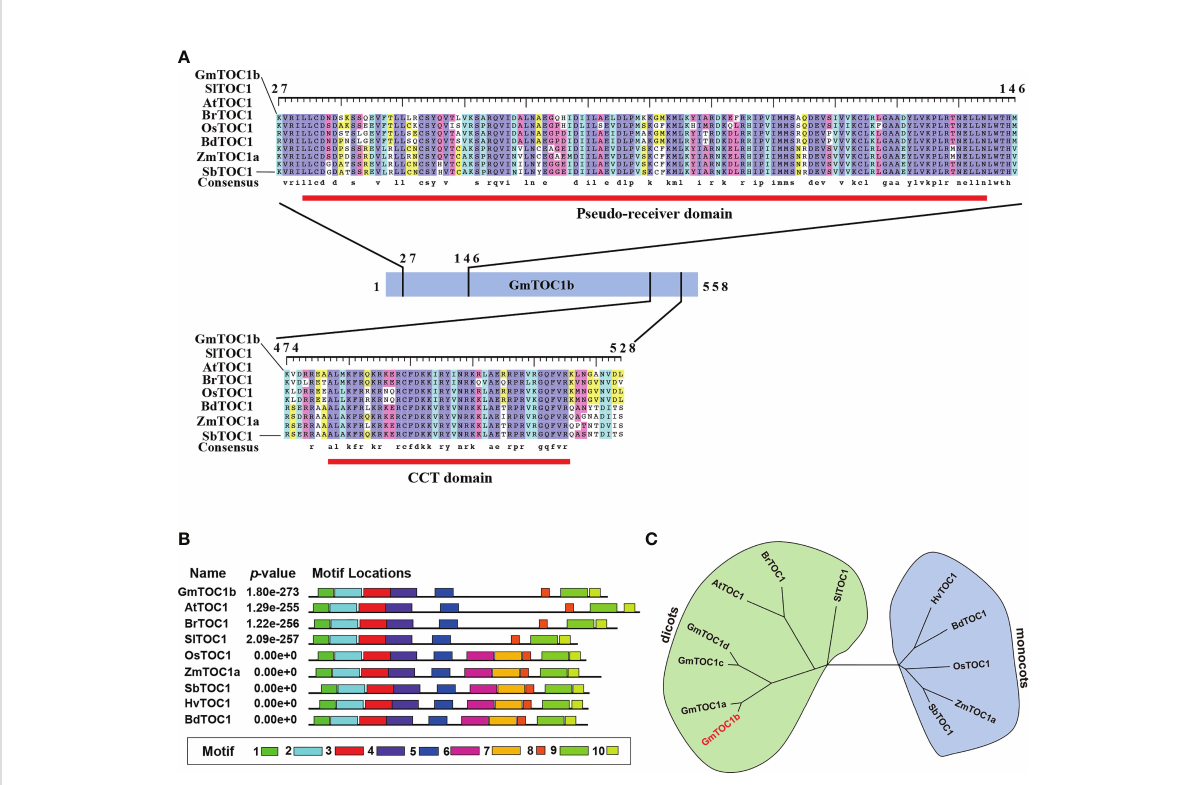
FIGURE 1 Analysis of TOC1 homologs in soybean and other plants. (A) TOC1 homologs contain conserved an N-terminal pseudo-receiver domain and a C-terminal CCT (CONSTANS, CO-LIKE, and TOC1) domain. Amino acid sequences were aligned using Clustal X. Red lines indicates the highly conserved domains. aa, amino acids; Sl, Solanum lycopersicum ; At, Arabidopsis thaliana ; Br, Brassica rapa ; Os, Oryza sativa ; Bd, Brachypodium distachyon ; Zm, Zea mays ; Sb, Sorghum bicolor . (B) Distribution of conserved motifs in TOC1 homologs. The MEME website tool was used to perform the analysis. (C) Phylogenetic analysis of TOC1 proteins. A neighbor-joining tree was constructed using full-length protein sequences, with bootstrap values set to 1,000